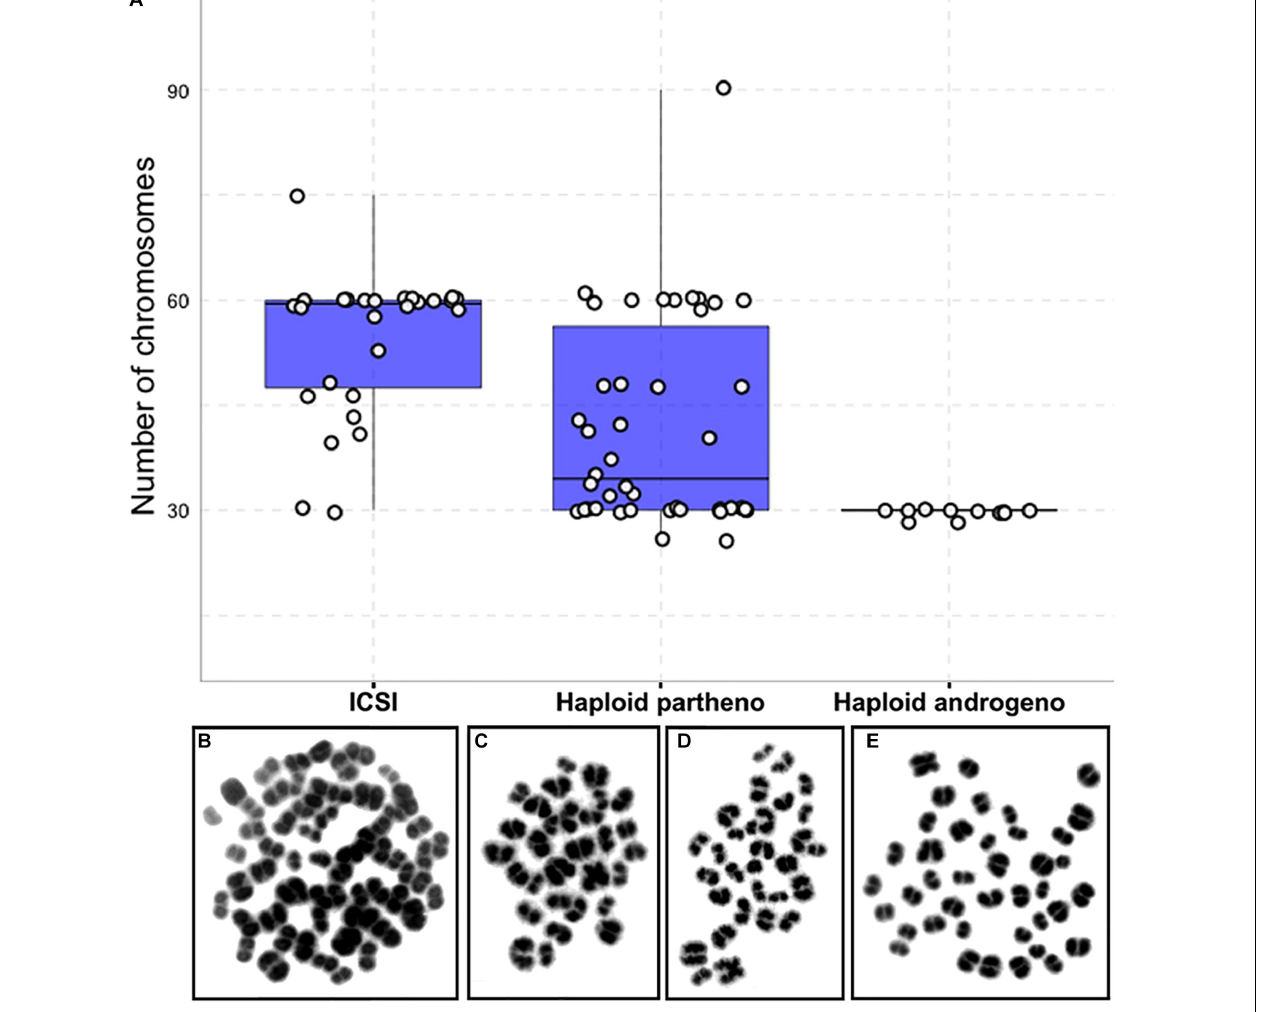
FIGURE 5 | Karyotype analysis of haploid and diploid morula stage (Day-6) embryonic blastomeres. (A) Group chromosomal number distributions showing mean values (blue horizontal lines) with standard deviations (red vertical lines). (B–E) Representative images of DAPI-stained chromosomal spreads of embryonic blastomeres from (B) diploid ICSI (60 chromosomes), (C) haploid parthenote (30 chromosomes), (D) haploid androgenote (30 chromosomes), and (E) aneuploid (40 chromosomes) parthenote embryo. ICSI, intracytoplasmic sperm injection using female-sorted semen; haploid partheno, haploid parthenogenetic embryos obtained by oocyte activation using ionomycin followed by cyclohexymide; haploid androgeno, haploid androgenetic embryo obtained by ICSI + oocyte enucleation.